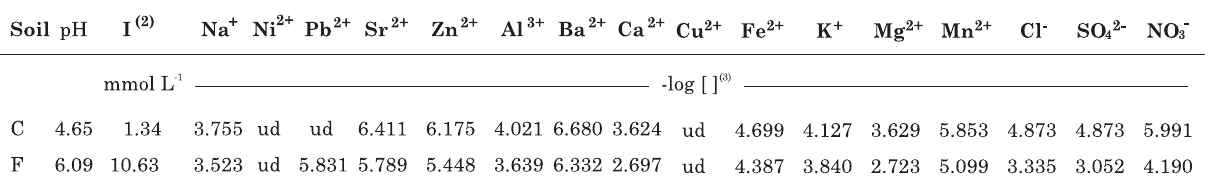
(1) Data represent mean value of three samples. (2) Ionic strength (I) calculated from the data in the table. (3) [ ] denotes concentration of a given species in mol L -1 in the extracts, respectively. ud: undetected values, below detection limits. C: control soil; F: sewage sludge-treated soil.